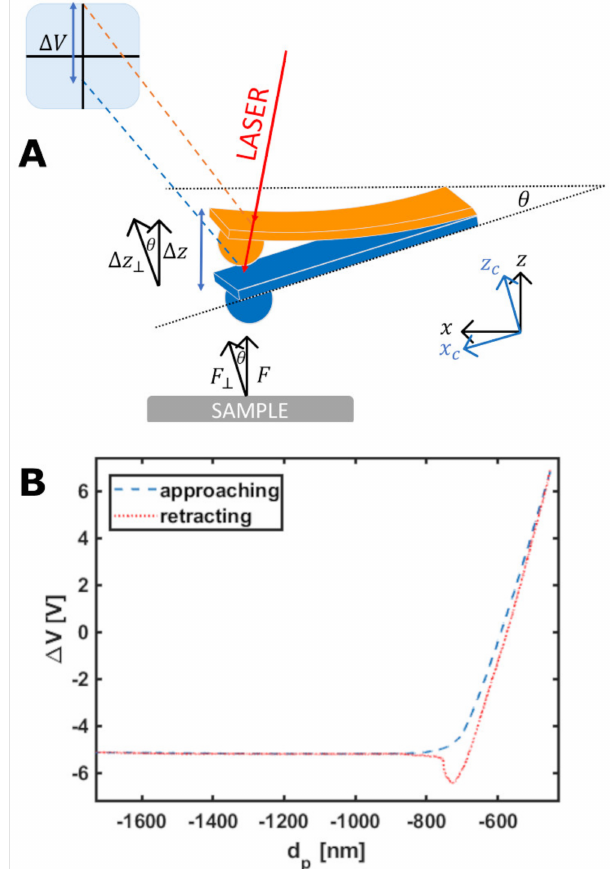
Figure 1. ( A ) Scheme of the optical beam deflection (OBD) system. The vertical displacement of the cantilever induced by the sensing of a force F perpendicular to the sample surface is detected on a segmented photodiode as a raw voltage signal ∆ V. The cantilever is typically mounted at an angle θ with respect to the sample surface. ( B ) A raw force curve, representing the photodiode output ∆ V as a function of the z-piezo displacement d p . Both the approaching and retracting branches of the curve are